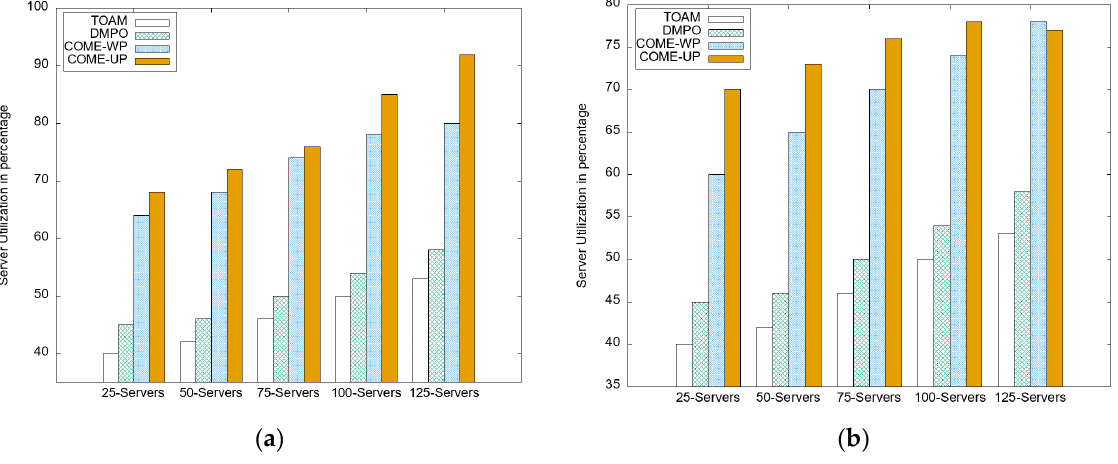
Figure 7. Server utilization; (𝐚) α = 0.25, β = 0.25, ϒ = 0.5; (𝐛) α = 0.3, β = 0.3, ϒ = 0.3. We used 50 sequences of LSTM as test data of user mobility patterns. The highest count of the error term is near to zero in this case, indicating the model’s acceptable error range. The observed error range is less than 0.5 during complete training, as shown in Figure A3.